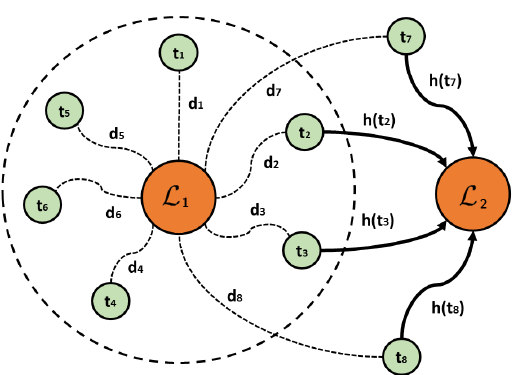
Figure 4. Transitions between local optima based on Escape-edges. The dotted circumference represents solutions at a distance less than D from L 1